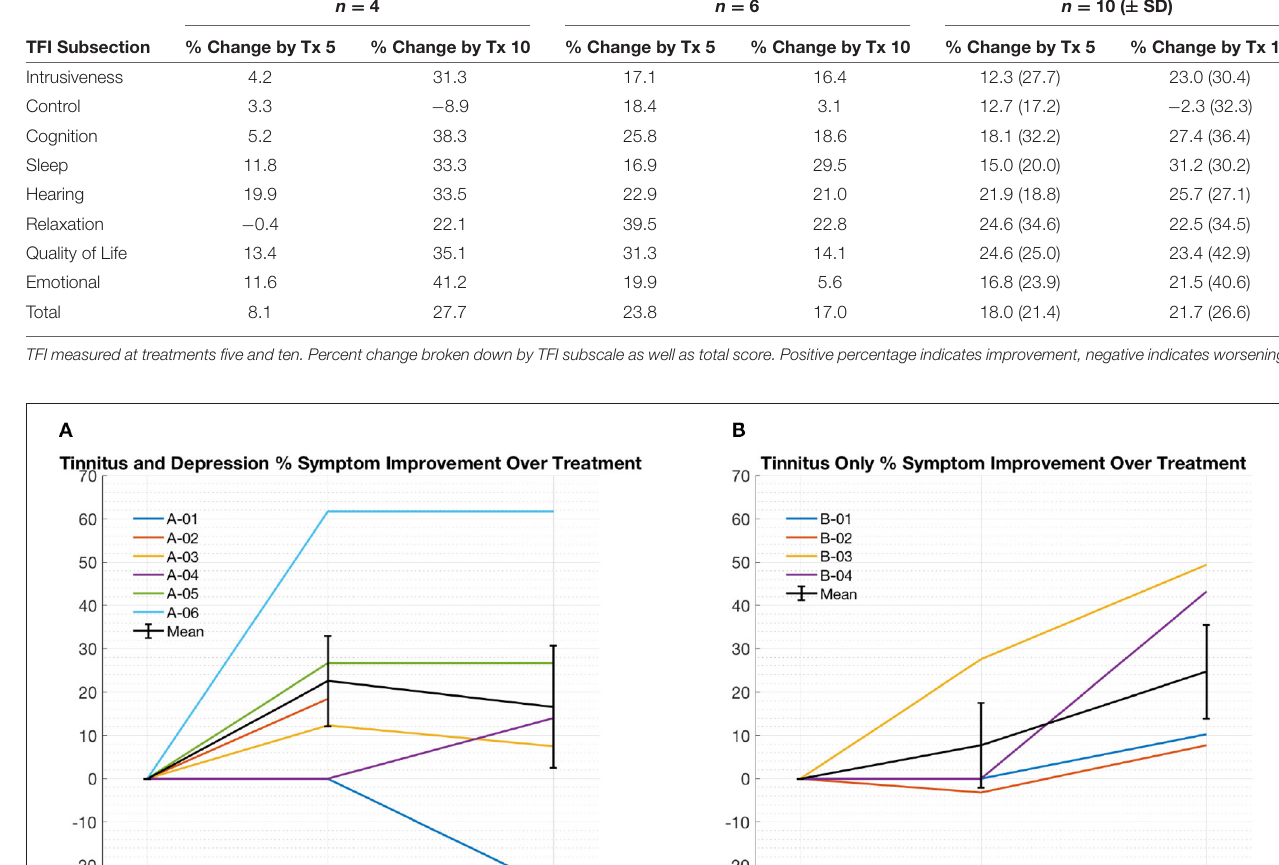
TABLE 2 | Mean Tinnitus Functional Index (TFI) score percent change in each group over the course of 10 treatments. Tinnitus only Tinnitus and depression Pooled aggregate n = 4 n = 6 n = 10 ( ±